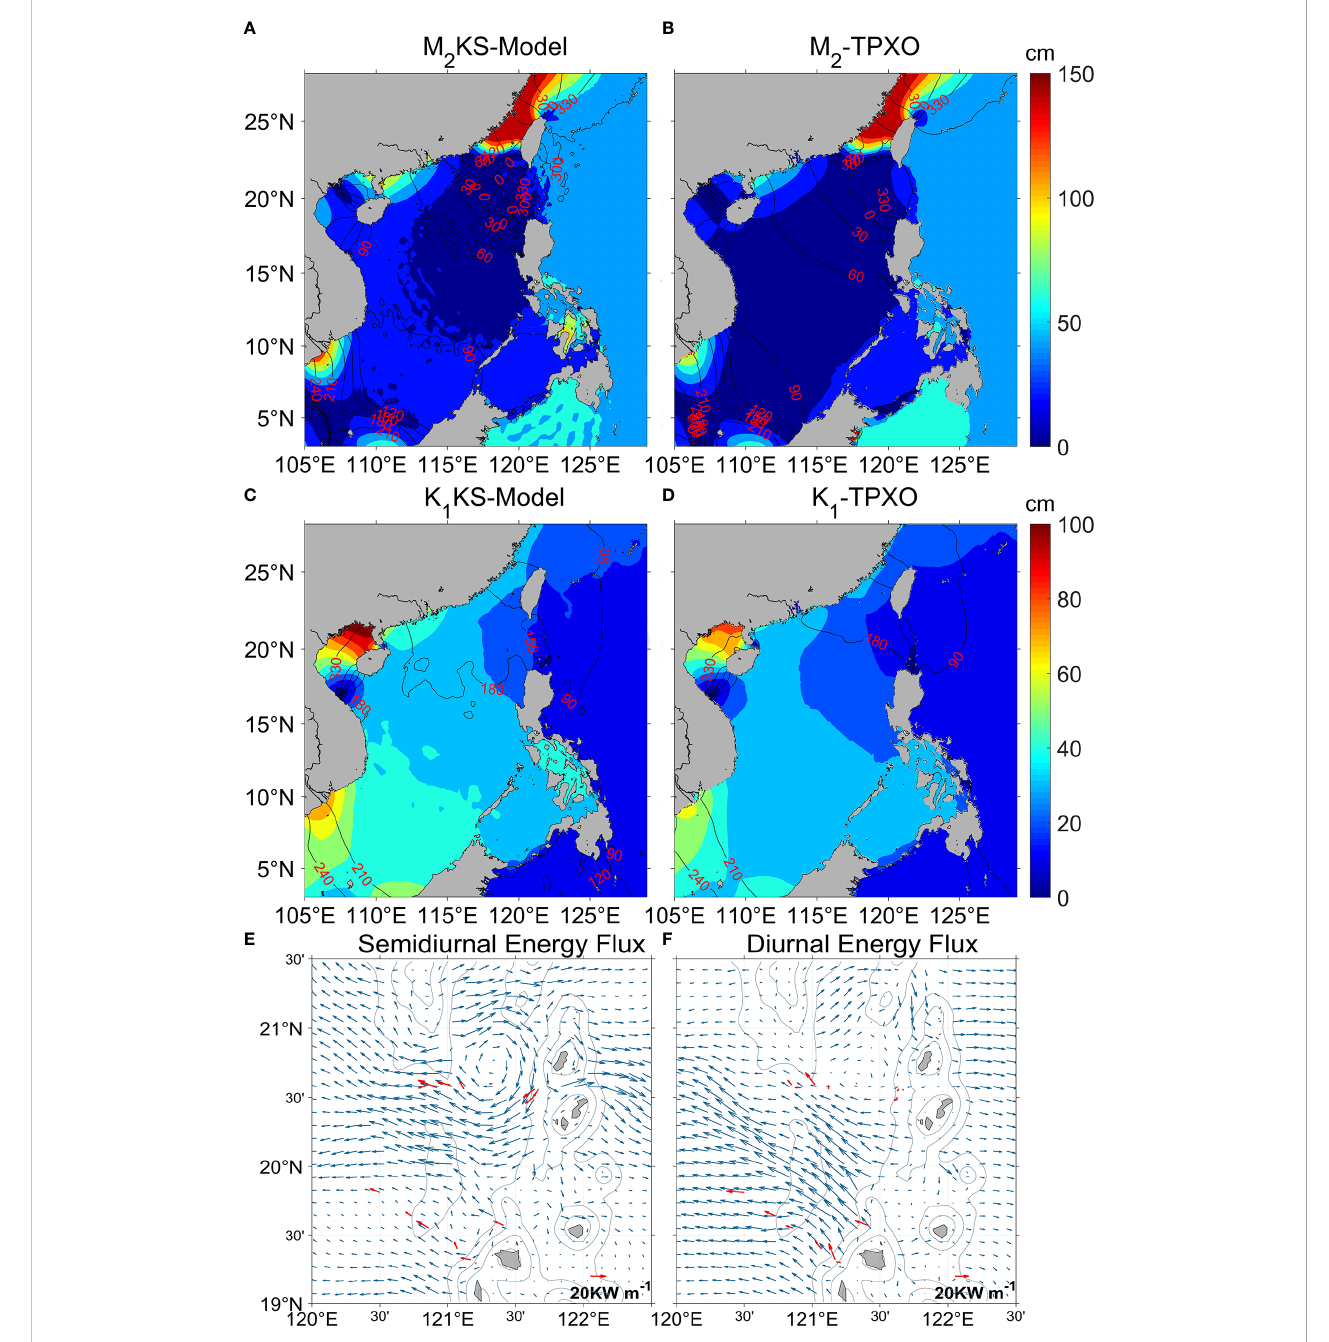
FIGURE 4 Modeled and observed cotidal chart and baroclinic energy fl ux. (A) Cotidal for case M 2 KS. Color indicates amplitudes (cm) and black contours give the cophase lines (degree). (B) M 2 from TPXO9 observations. (C) Cotidal chart for case K 1 KS. (D) K 1 of TPXO9. (E) Baroclinic energy fl ux from in situ observations (red, Alford et al., 2011) and our experiment forced by semidiurnal (M 2 and S 2 ) tide (blue). (F) The same as (E) but for diurnal (K 1 and O 1 ) tide.